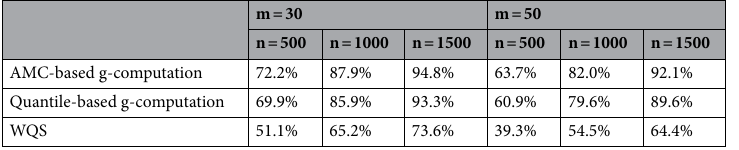
Table 1. Average True Positive Rates (TPRs) of the three methods under monotonic effects. Average TPR was calculated across 1000 simulations; m was the number of exposures; n was the sample size.